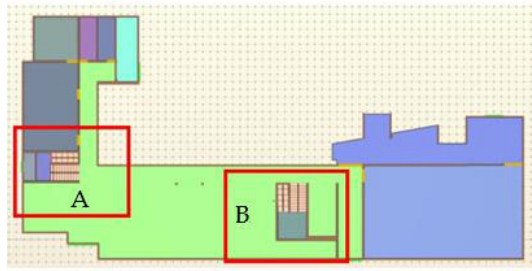
Figure 1. Curve of average temperature data on the third floor.